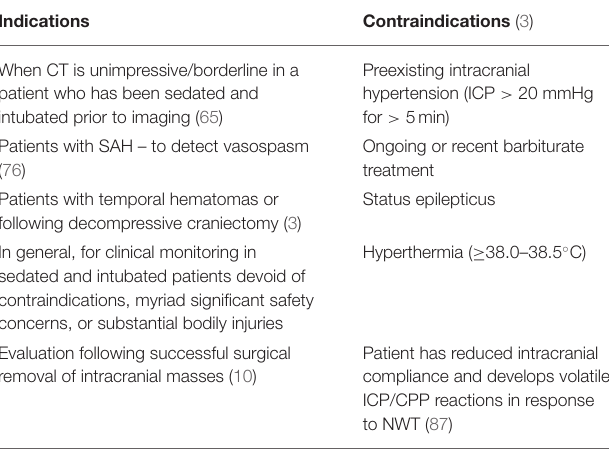
TABLE 1 | Brief outline of indications and contraindications to the NWT.